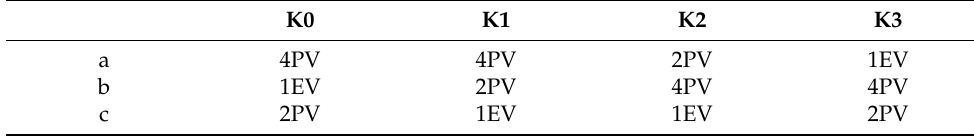
Table 10. Configurations for distribution of load groups to connection phases. K0 K1 K2